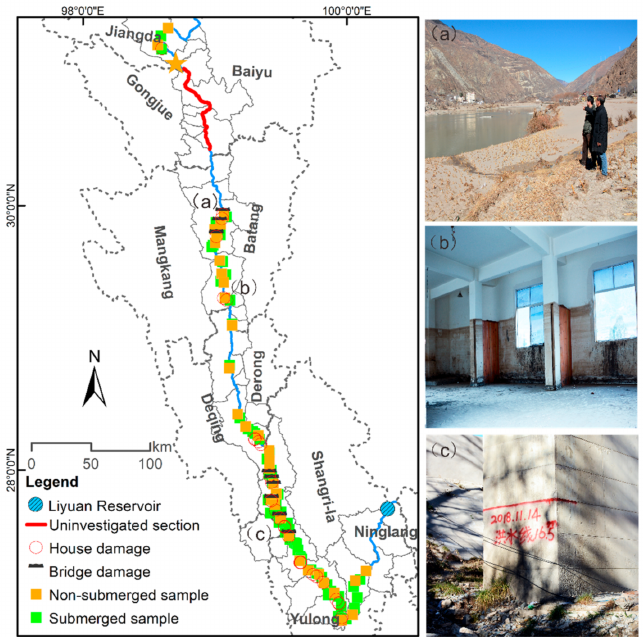
Figure 2. Field validation sites. Left: the distribution of validation sites; Right: ( a – c ): Scene photos documenting flood